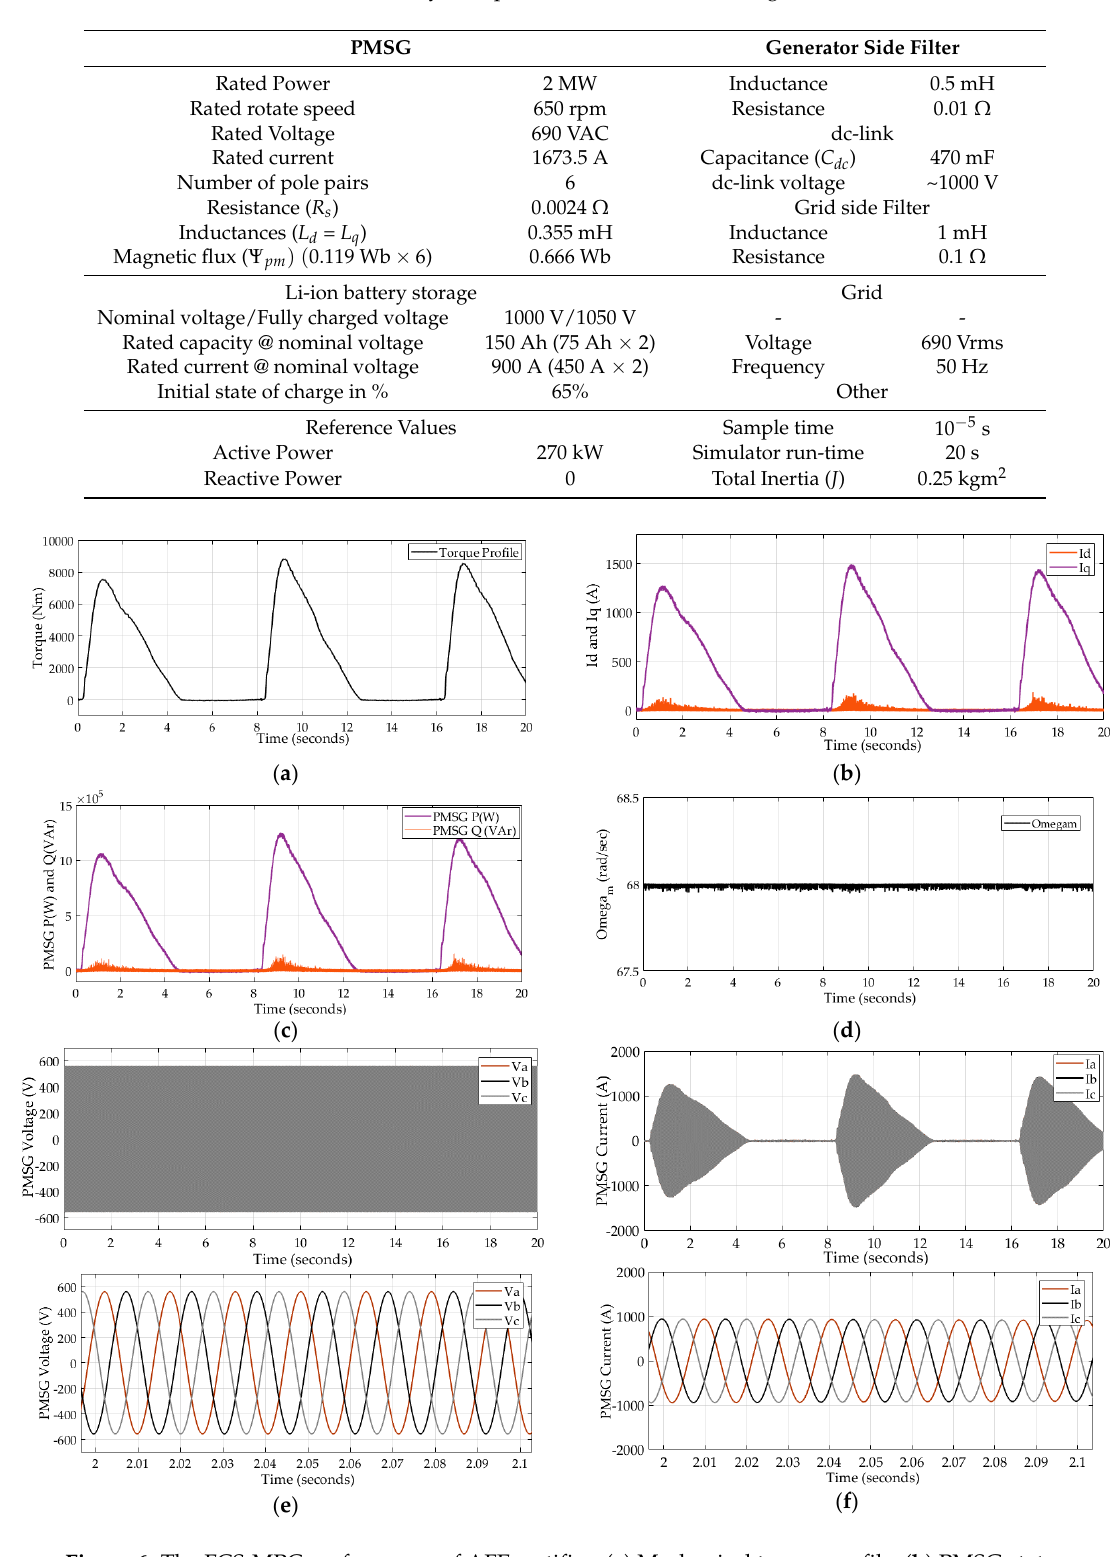
Figure 6. The FCS-MPC performance of AFE rectifier: ( a ) Mechanical torque profile; ( b ) PMSG stator current in dq rotational reference frame; ( c ) Generator active power P (W) and reactive power Q (VAr); ( d ) Generator rotor angular speed ω m (rad/sec); ( e ) Generator peek voltage V pk (V); ( f ) Generator peek current I pk (A).